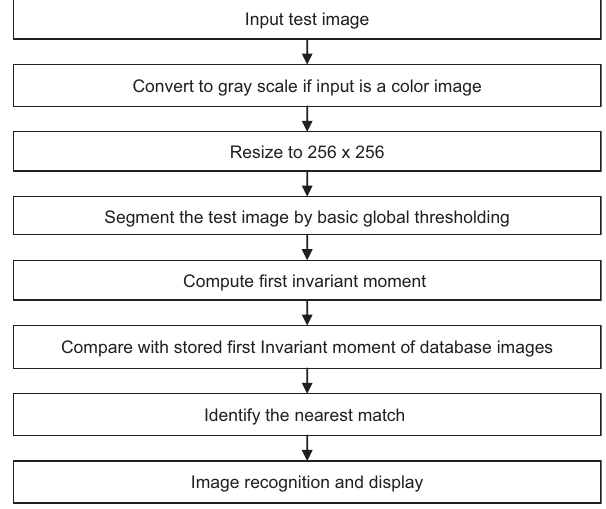
Figure 1. Block Diagram of the Invariant Moment